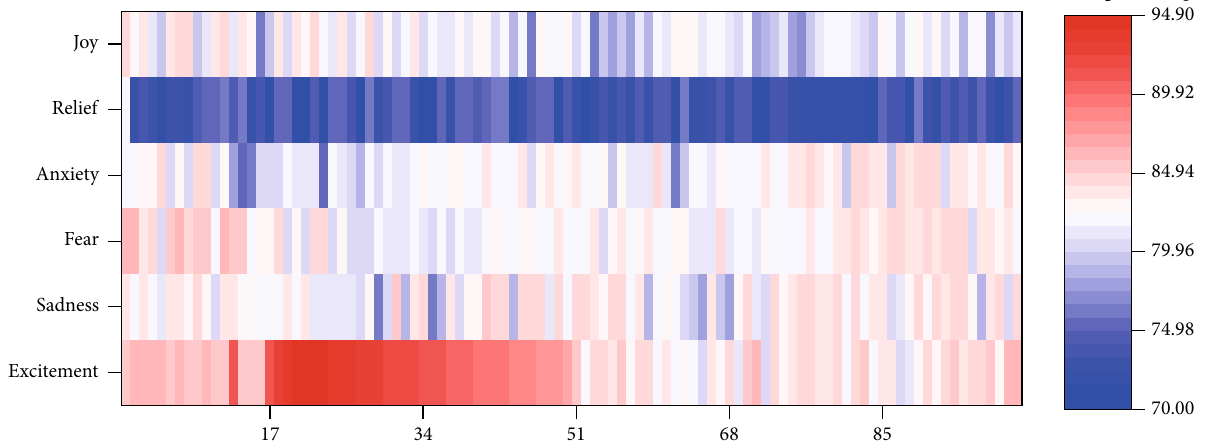
Figure 7: Semantic matching speech emotion recognition experimental results data